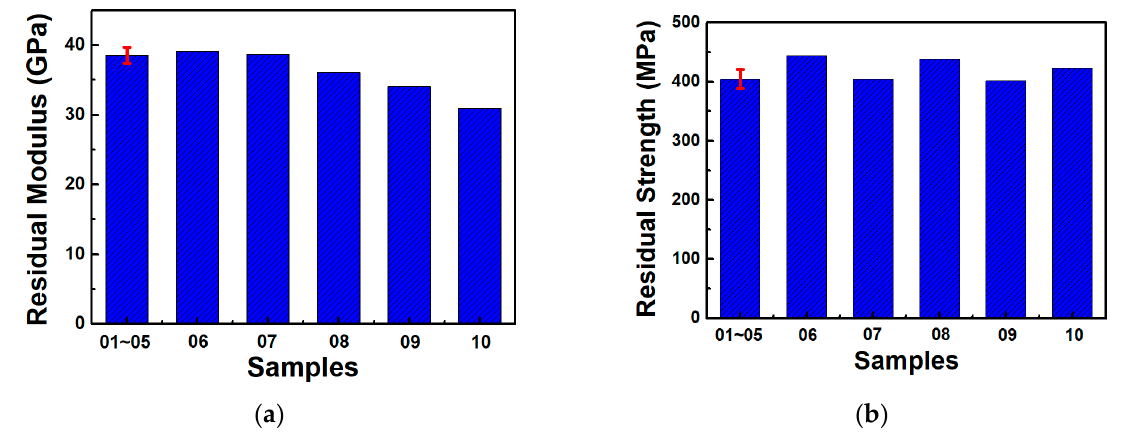
Figure 12. Residual modulus ( a ) and residual strength ( b ) due to the phased damages (samples 01–05 represent the initial typical values, while the samples 06/07/08/09/10 demonstrate the residual values).